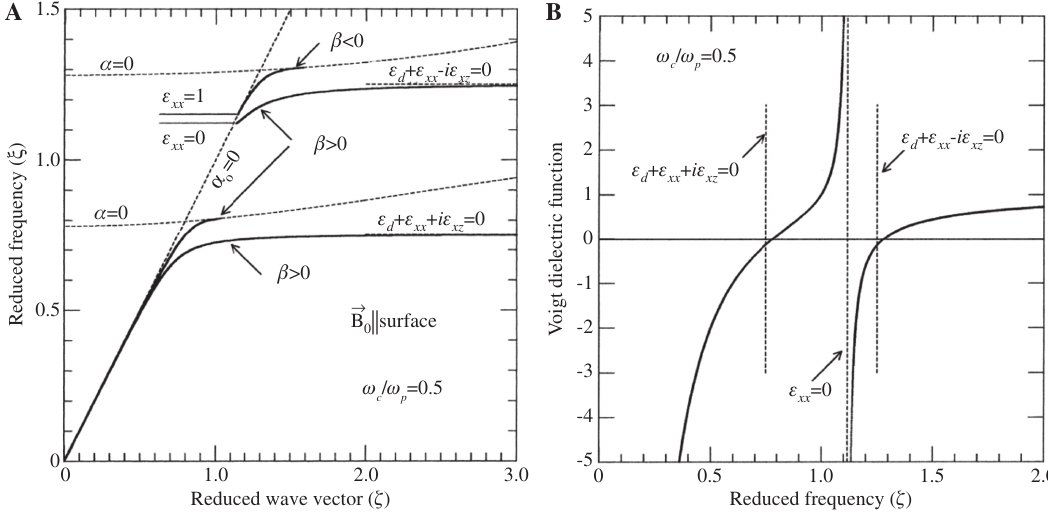
Figure 2: (A) Dispersion curves of SMPs at the interface of n -type InSb and air in the Voigt configuration (solid lines). (B) Voigt dielectric constant ε as a function of frequency (Reprinted from Surf Sci Report, 41, Kushwaha MS, Plasmons and magnetoplasmons in semi- V conductor heterostructures, 1–416, Copyright (2001), with permission from Elsevier.).